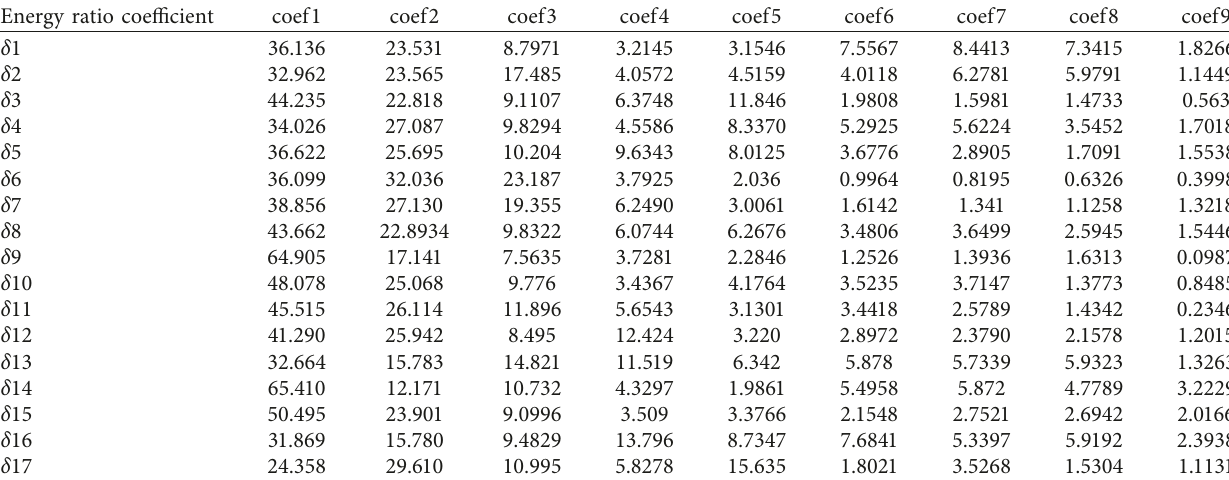
Table 6: Analysis of the energy ratio coefficient of wavelet decomposition components by each sample. Energy ratio coefficient